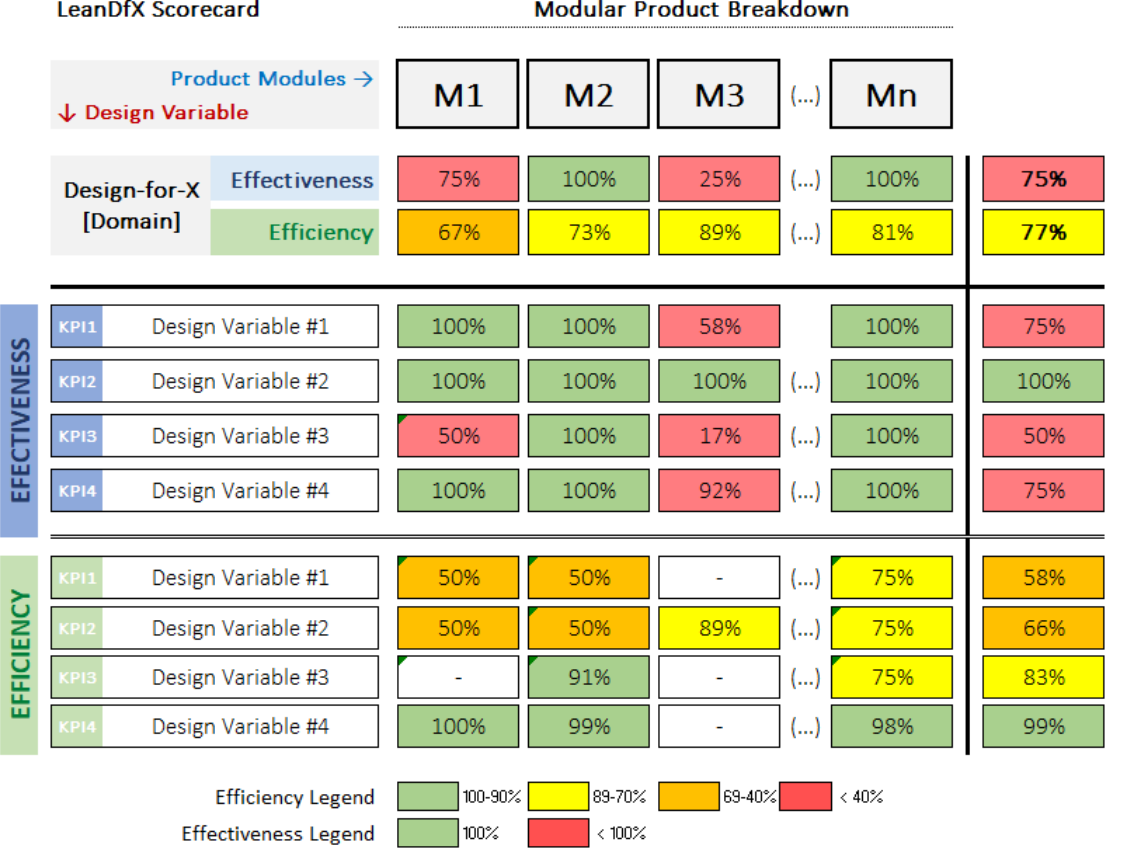
Figure 7. Bottom ‐ up aggregation of efficiency and effectiveness values (modules, system and prod ‐ uct) [2].